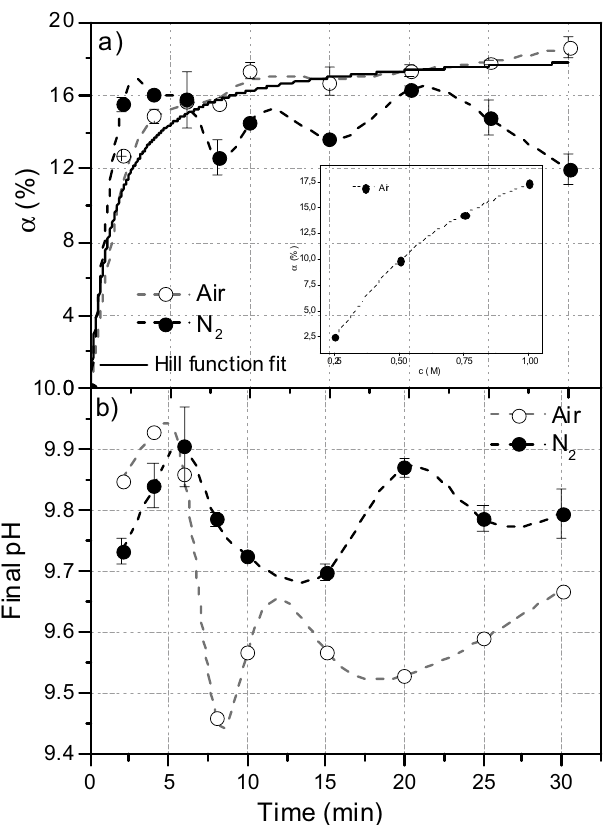
Figure 1. For microwave-assisted aqueous NH 4 CN polymerization (1 M), in the presence of air or under anoxic conditions: ( a ) Degree of conversion α vs. reaction time; ( b ) pH values of the suspensions corresponding to the crude reactions vs. reaction time. Note that the dashed lines are only to guide the eyes to more clearly see the evolution of the system against the reaction time. These lines are not fitted to any kinetic model; it is just a slight connection provided for the software programme. However, the solid line is fitted to a Hill equation of the data collected under air conditions. The inset plots represent the conversion α vs. NH 4 CN concentration for a fixed reaction time of 10 min for polymerizations conducted in the presence of air. At least three independent experiments were conducted to calculate the conversion data for the NH 4 CN polymerizations under anoxic